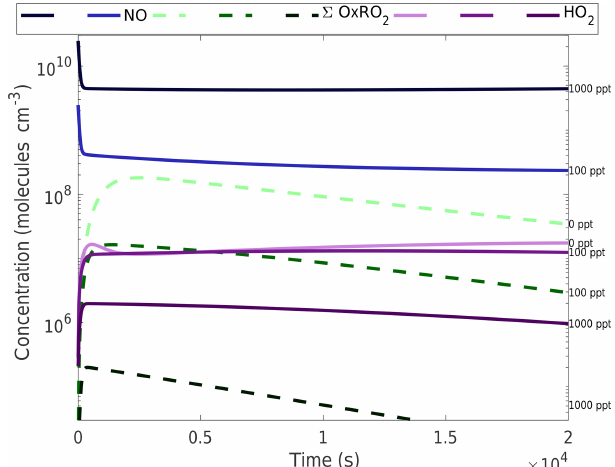
Figure 4. Concentration time series of HO 2 , NO, and oxidized RO 2 at various NO x levels. The numbers along the right-hand y axis refer to the NO x concentration for each simulation, which is also indicated by the shading of each curve, going from light at low NO x to dark at high NO x . HO 2 remains reasonably stable near 10 7 moleculescm − 3 (0.3pptv). NO x is introduced as NO and drops to a steady state as it reacts with HO 2 and RO 2 to form NO 2 , which in turn photolyzes. By 1000pptv of added NO x the NO greatly exceeds the HO 2 and somewhat suppresses HO 2 concen- trations. The oxidized RO 2 ( (cid:80) Ox n RO 2 ) reaches a peak just over 10 8 moleculescm − 3 at zero NO x before gradually decaying as a function of